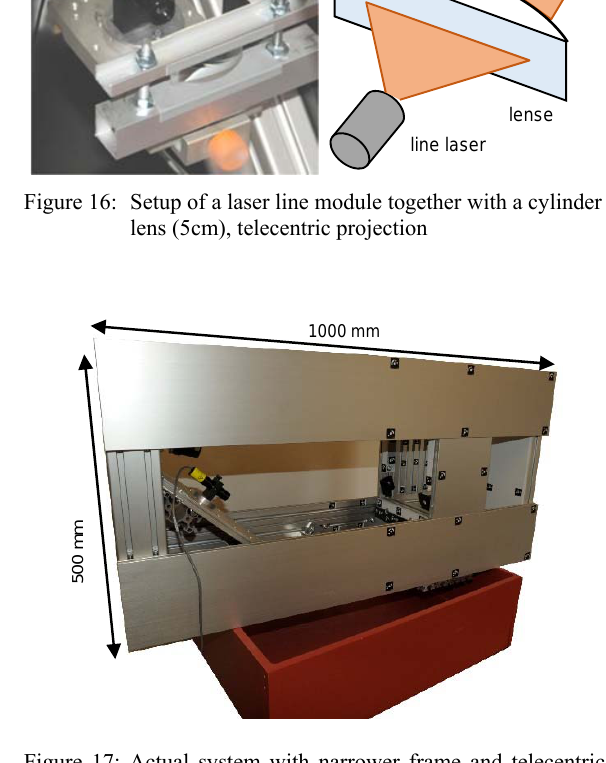
Figure 17: Actual system with narrower frame and telecentric laser line. The basin under the system is for test purposes.